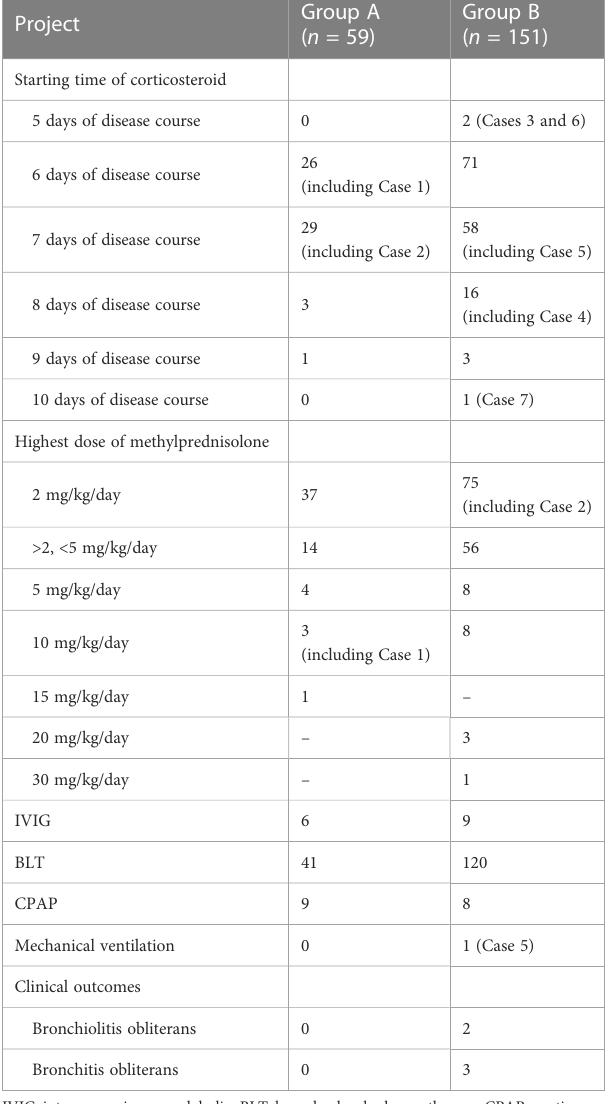
TABLE 3 The dose and timing of methylprednisolone treatment in the patients with sequela (Cases 3 – 7).